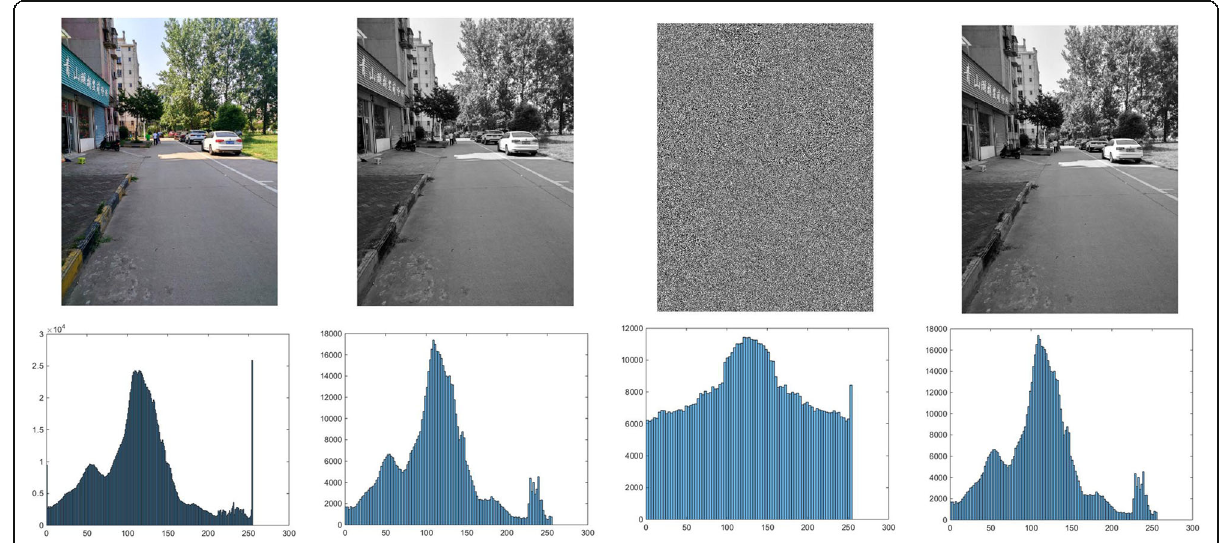
Fig. 4 Comparison of encryption and decryption of Color Photo